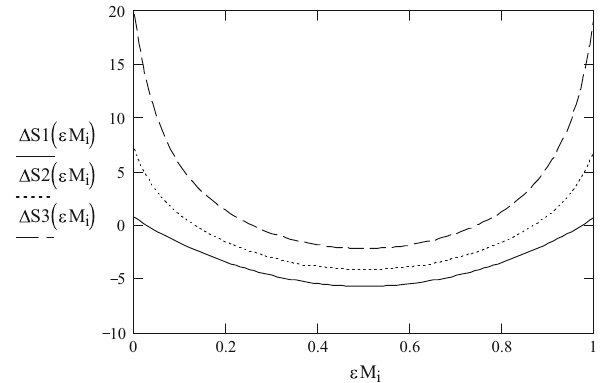
Fig. 2 The solid, dotted, dashed curves of the dependence of entropy difference (cid:4) S (cid:7) on ε M inunitsof π( GM ) 2 for (β l p ) 2 = 2 , 6 , 10,respec- tively, with ψ 0 = 0 and α l p = 1 for simplicity